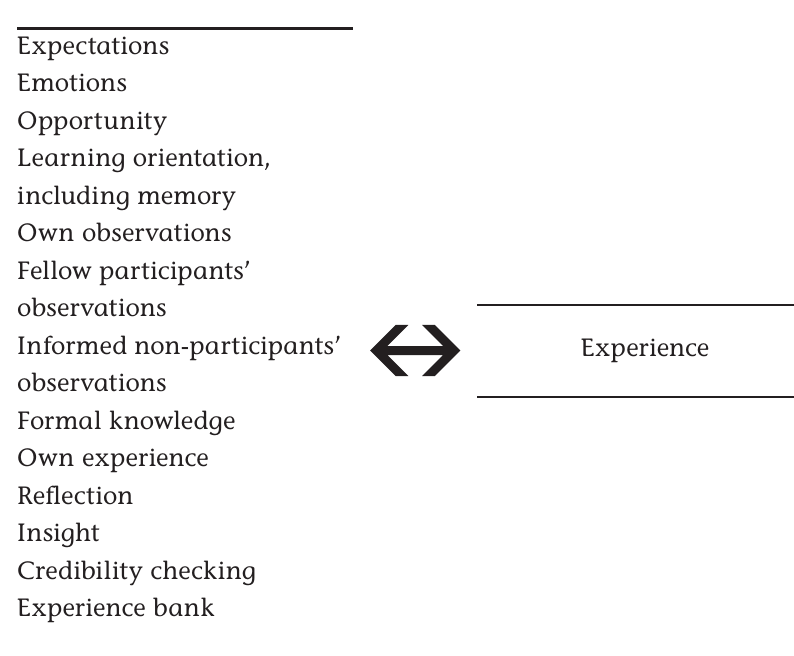
Figure 5: Overview of the elements involved in Informal